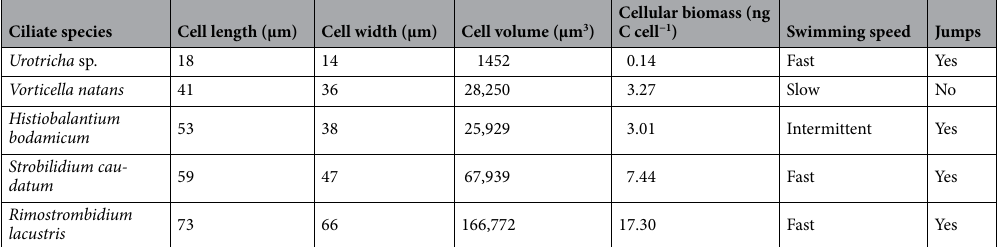
Table 1. Average cell size, volume, carbon biomass and swimming behaviour of the study ciliates. Biomass was converted from volume assuming pg C cell −1 = 0.261 × volume 0.860 if cell volume is less than 3000 µm 3